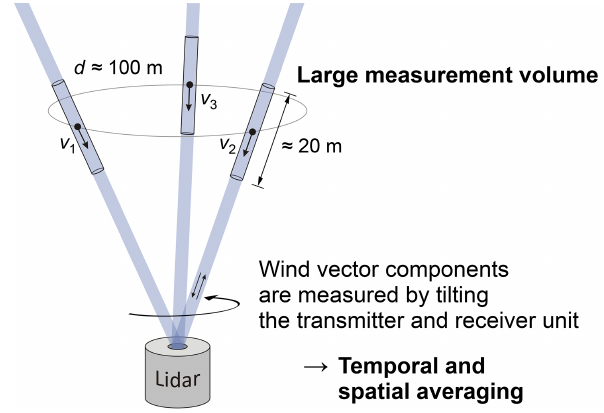
Figure 1. Principle of a conventional monostatic lidar.